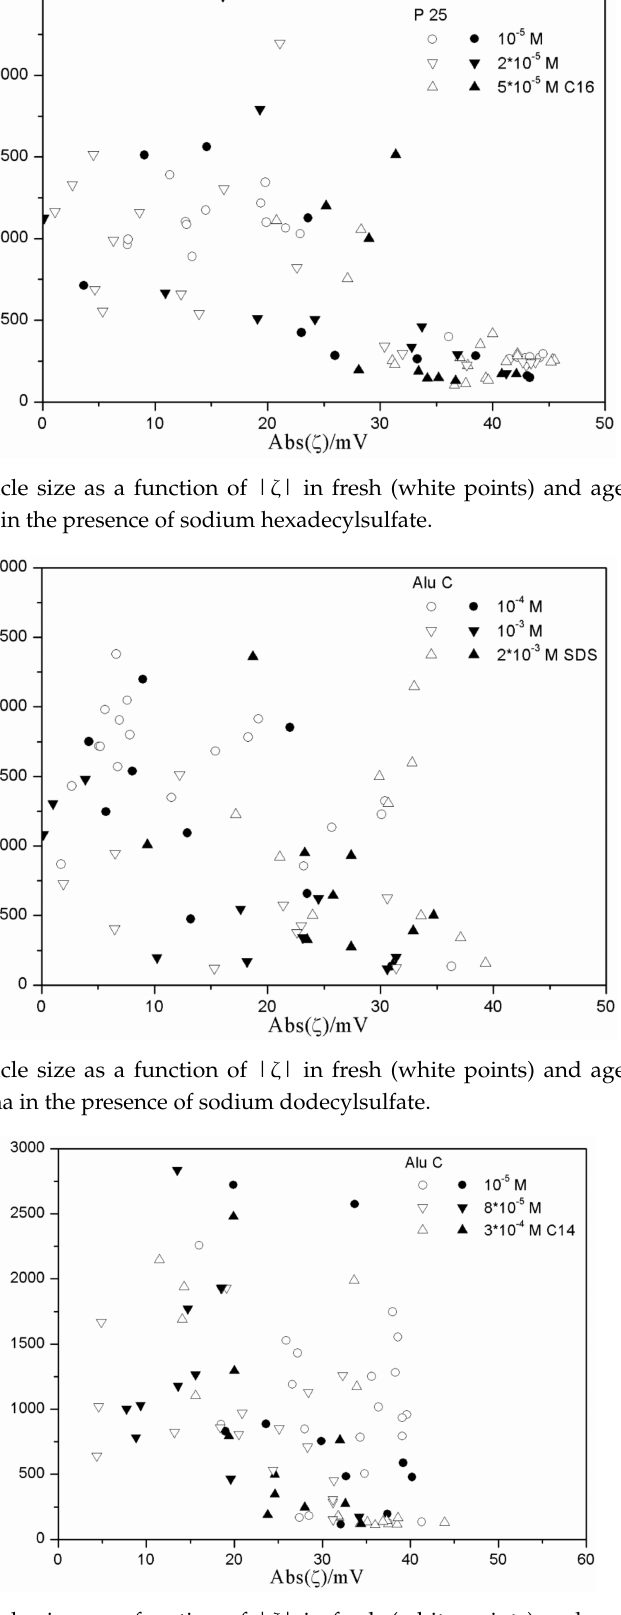
Figure 15. The particle size as a function of | ζ | in fresh (white points) and aged (black points) dispersions of alumina in the presence of sodium